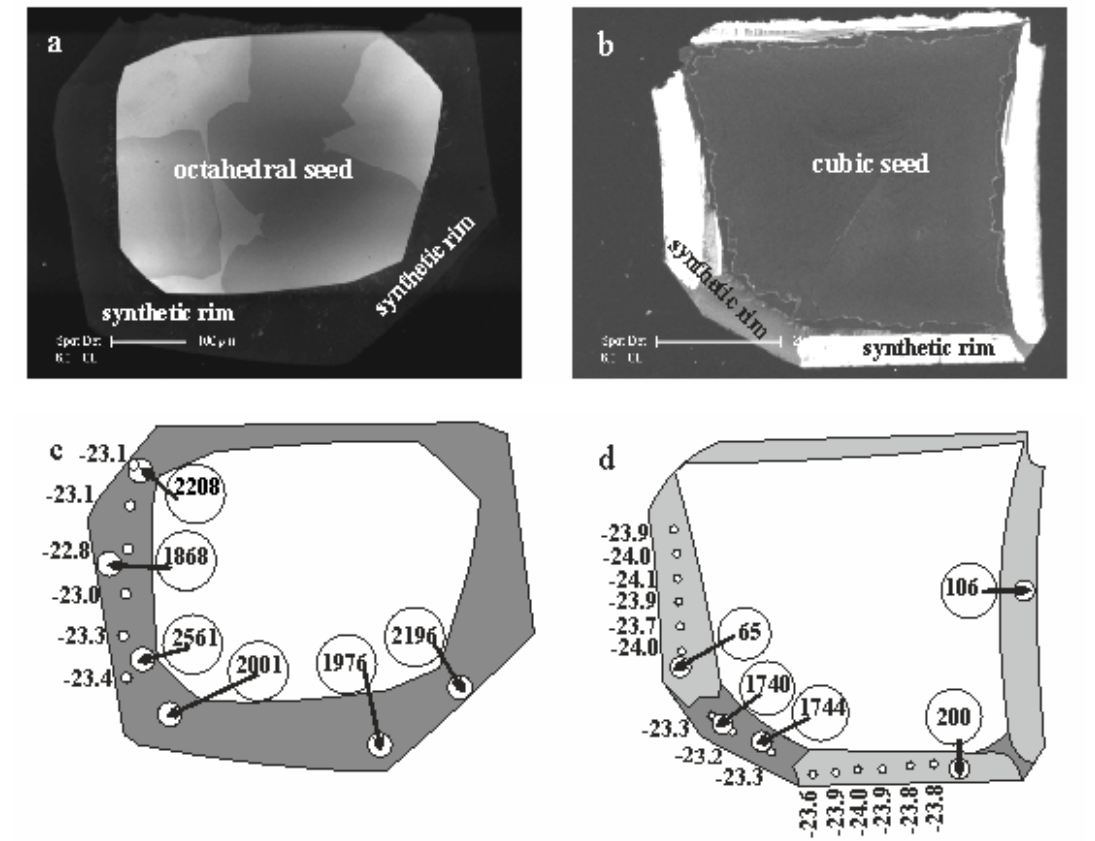
Figure 1. Cathodoluminescence images of investigated samples 268-1 ( a ) and 268-2 ( b ) and schematic pictures of synthetic rims ( c , d ). The cores represent seed crystals: 268-1—octahedral to dodecahedral seed crystal, 268-2—cubic seed crystal. Rims grown from a single carbonate melt. On schemas, light-grey parts related to cubic growth and dark grey parts related to octahedral growth. Small circles indicate positions of carbon isotope analysis. Bigger circles correspond to positions of nitrogen analysis.